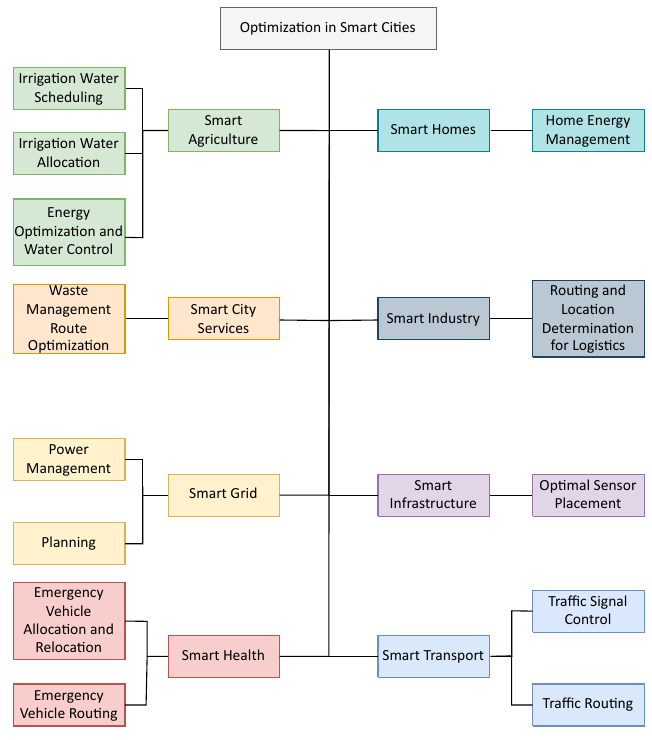
Figure 9. Optimization applications in IoT based Smart